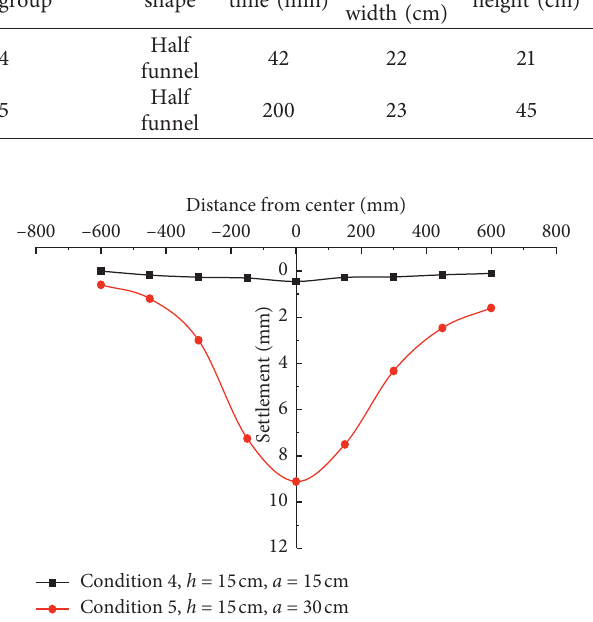
Figure 11: Effect of distance between loss channel and pipeline on settlement tank. Table 4: Experiment 4 and 5 cavity parameter.